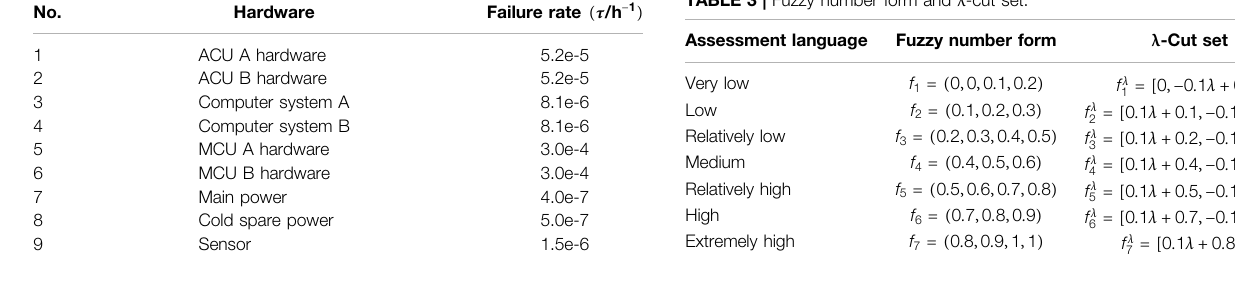
TABLE 3 | Fuzzy number form and λ -cut set.